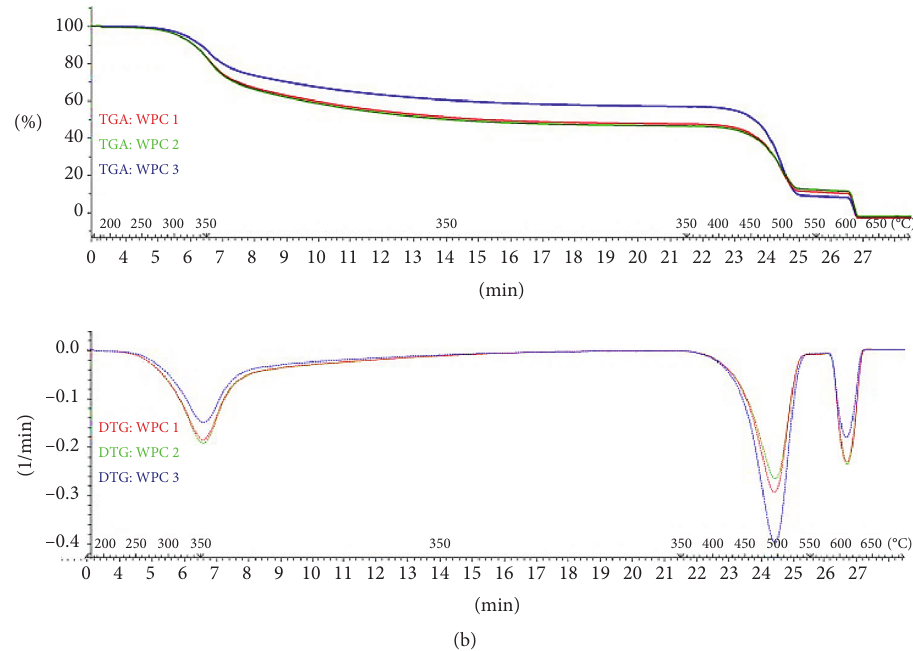
Figure 3: The thermogravimetric analysis profile and derivative weight of (a) temer musa with the three regions of weight changed and (b) wood-based material [33] for comparison. Table 2: Proximate analysis results of temer musa branches.